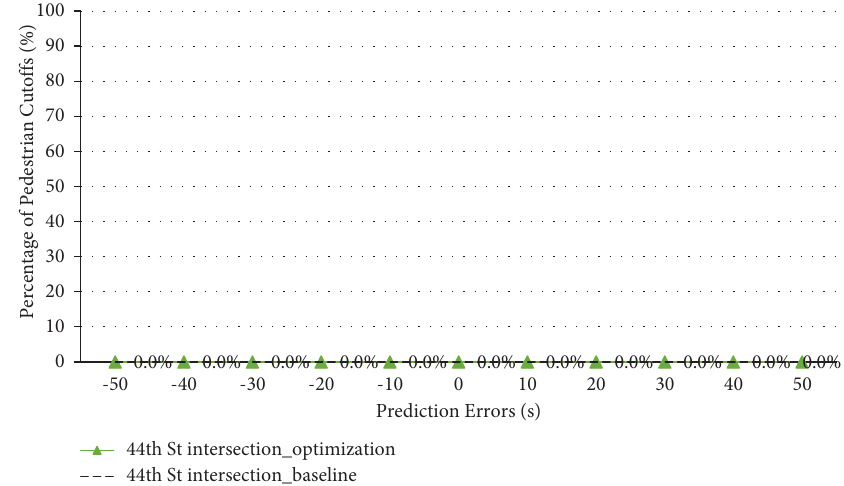
Figure 11: Percentages of pedestrian phase cutoffs in relation to prediction errors at 44th Street intersection.